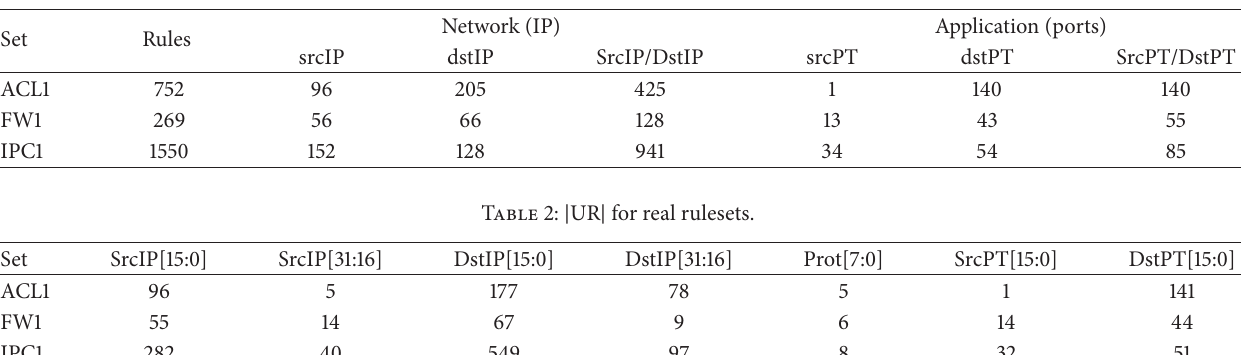
Table 1: | UV | for real rulesets.